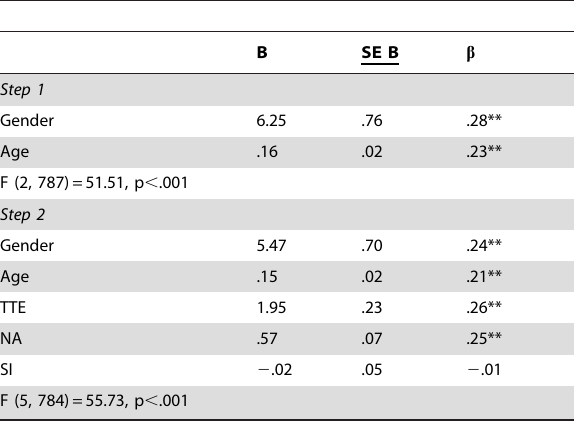
Table 6. Regression analysis with IES total score as dependent